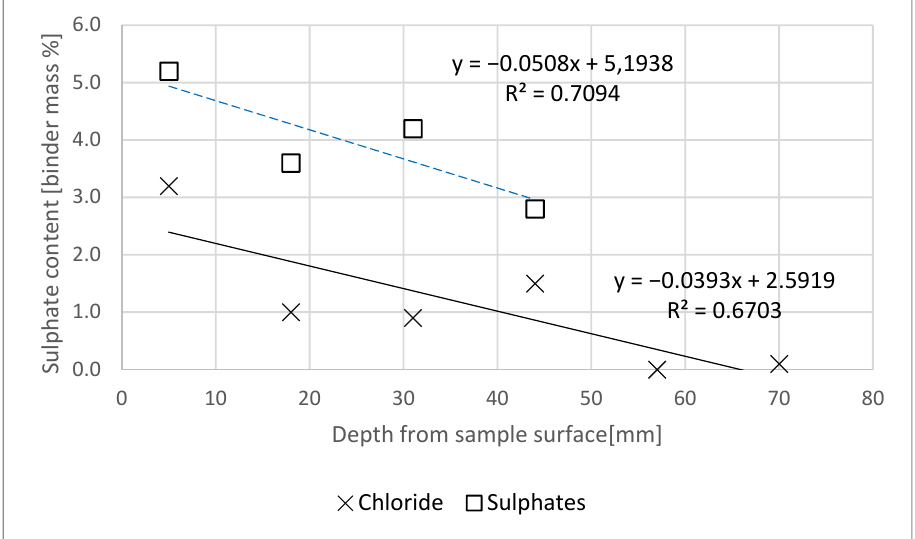
Figure 4. Chloride and sulphate ion content profile per specimen depth, relative to binder weight.